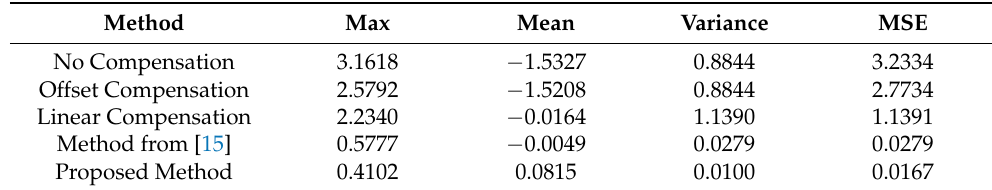
Table 9. Experimental results, with aligned axes and uninclined sensor.